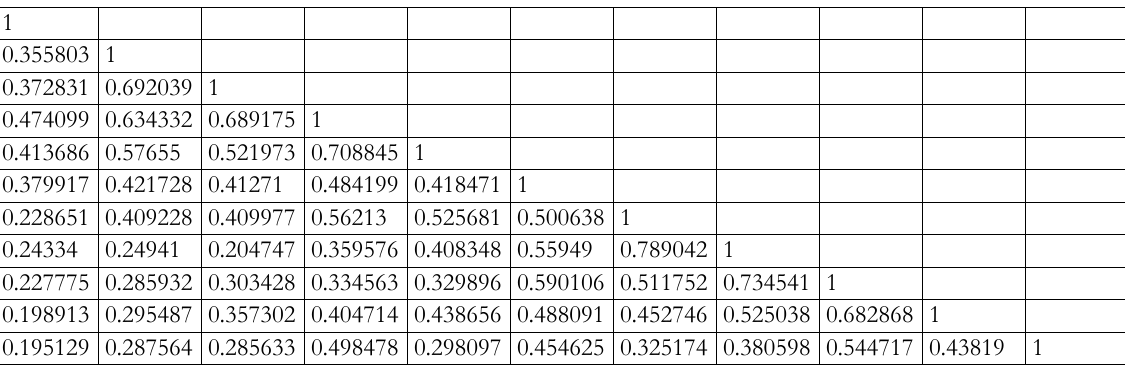
Table 20. Pearson Correlation Analysis